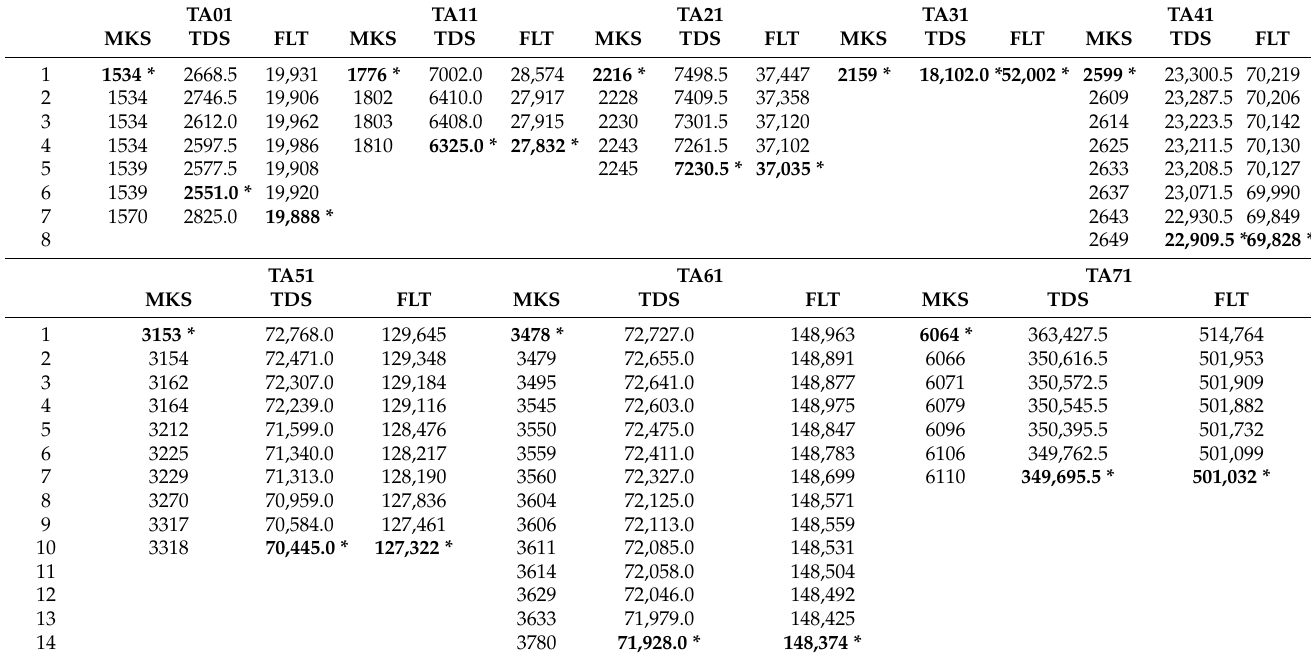
Table A6. Non-dominated solutions obtained by SS/LS for the JSSP instances proposed by [41].